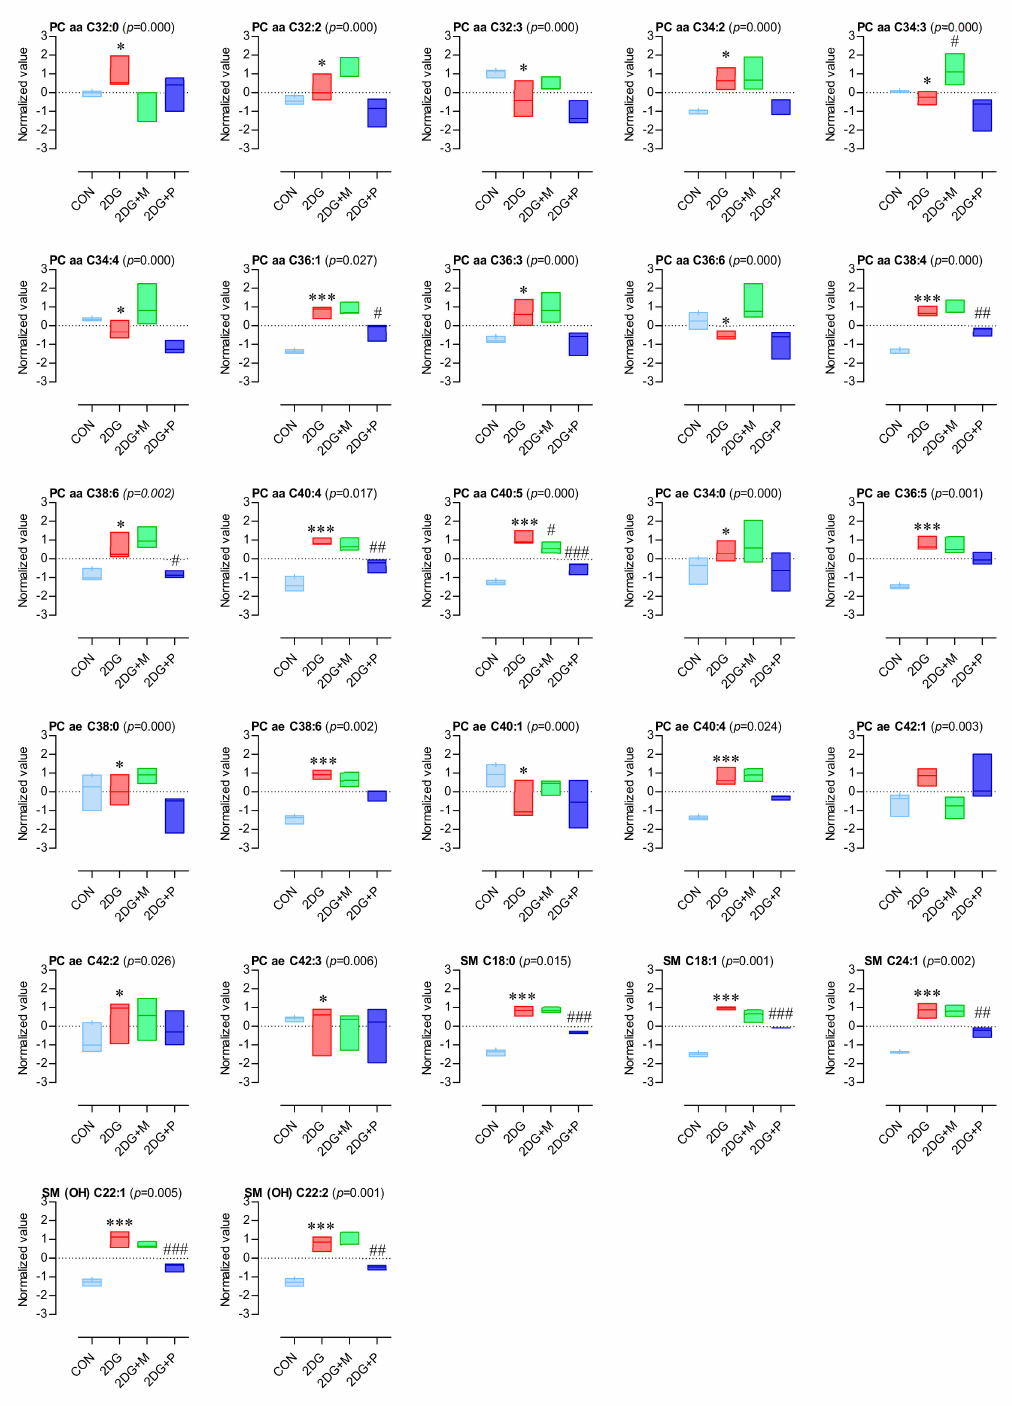
Figure 7. Box plot of altered lipid levels. The normalized values of all the experimental groups were determined by the MetaboAnalyst, a web-based platform (normalization by median, auto-scaling). Significant di ff erences among the groups were assessed using one-way ANOVA ( p -value < 0.05, Tukey’s HSD). The box plots were generated using GraphPad Prism; One-way ANOVA with Tukey’s multiple comparison test; ***: p < 0.001, *: p < 0.05 (vs CON); ###: p < 0.001, ##: p < 0.01, #: p < 0.05 (vs